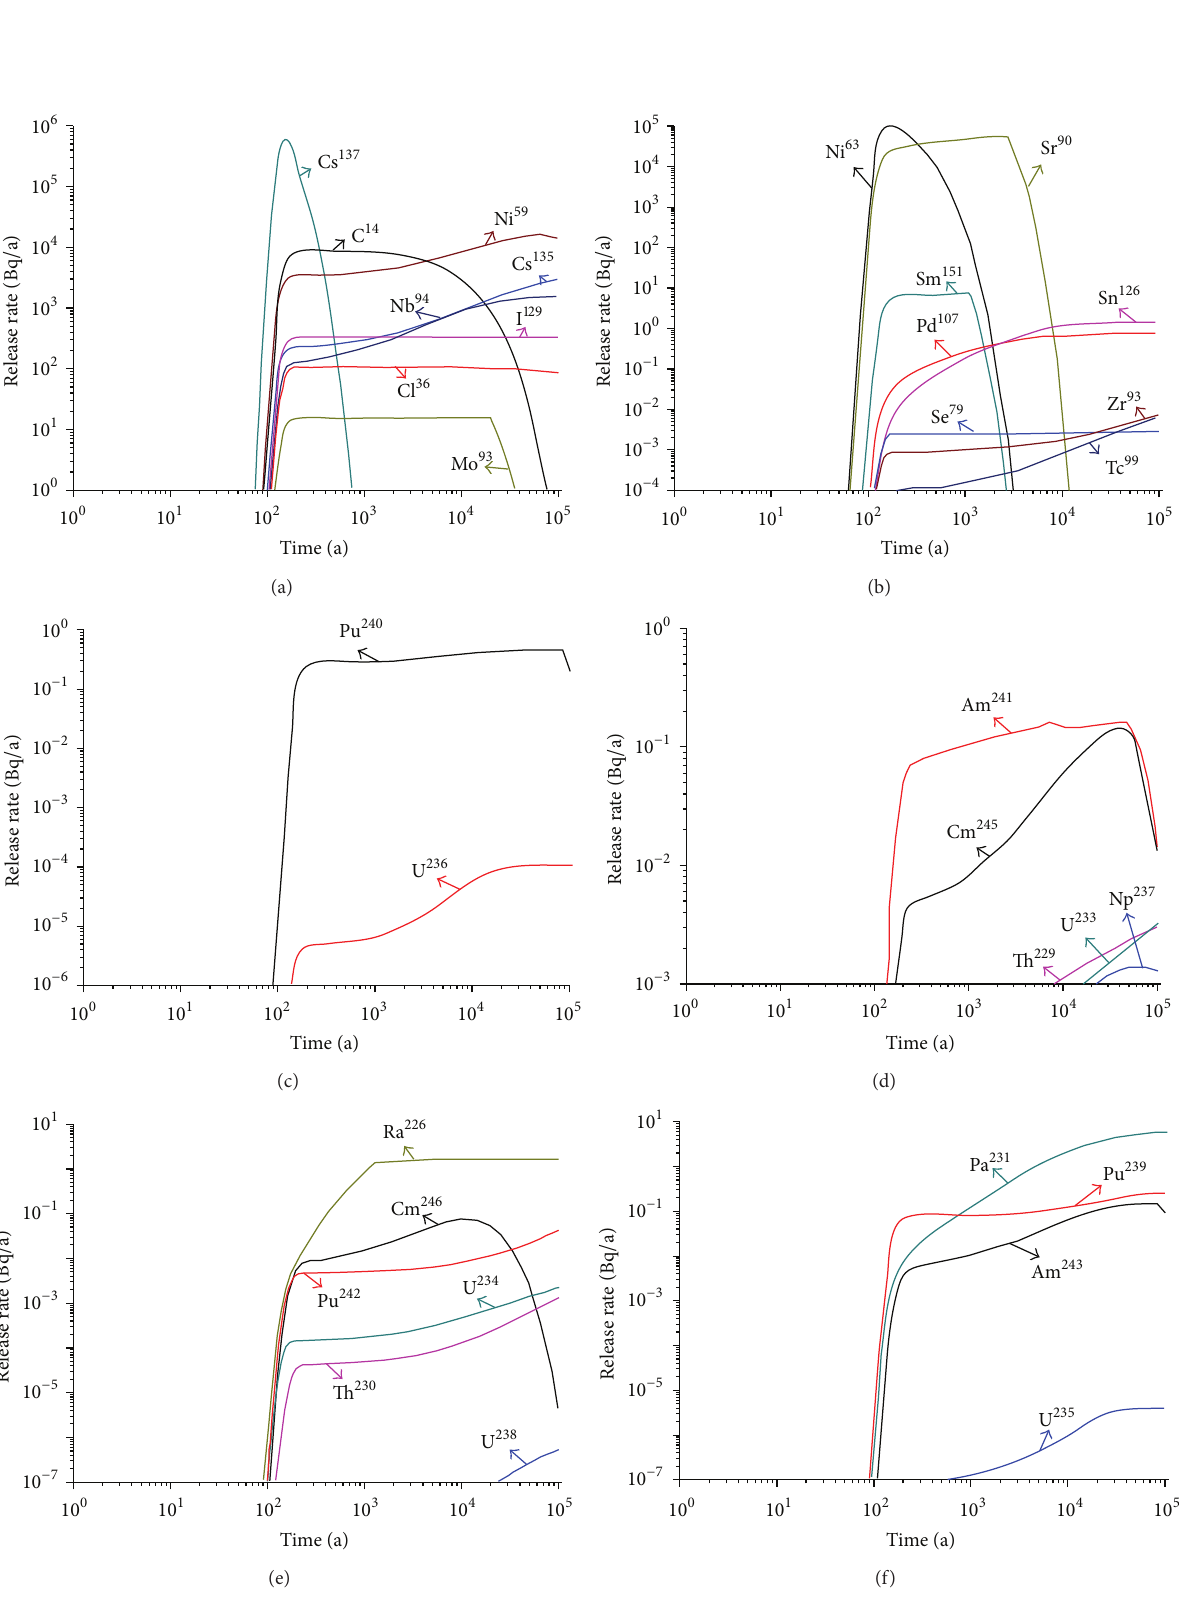
Figure 12: Release rates to the environment in Bq/a of spent fuel relevant